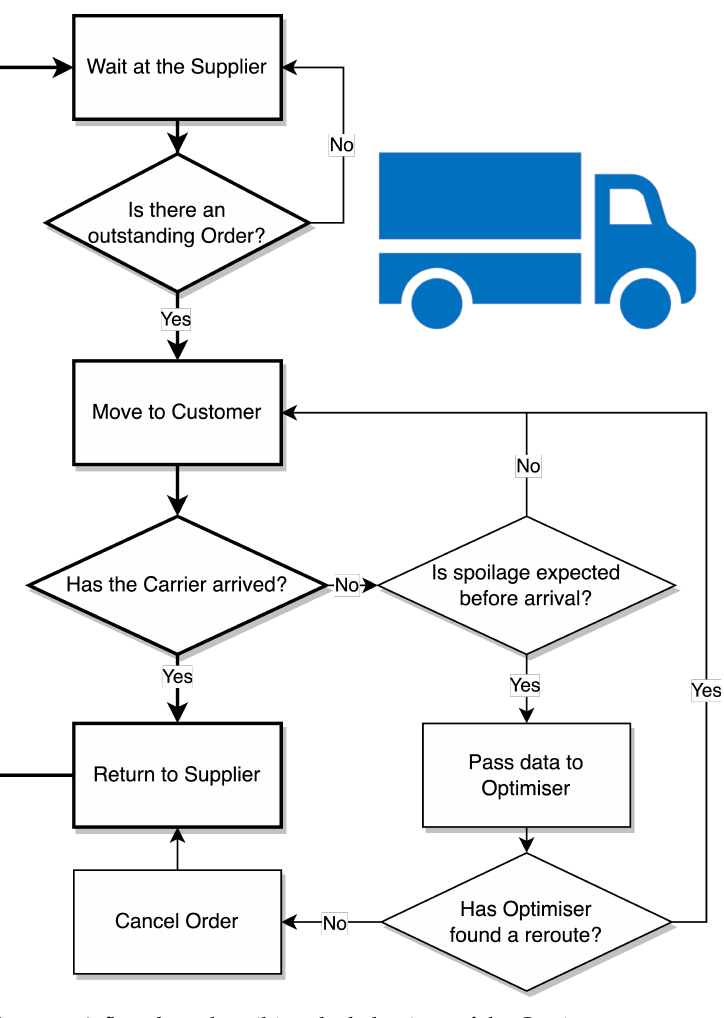
Figure 6. A flowchart describing the behaviour of the Carrier